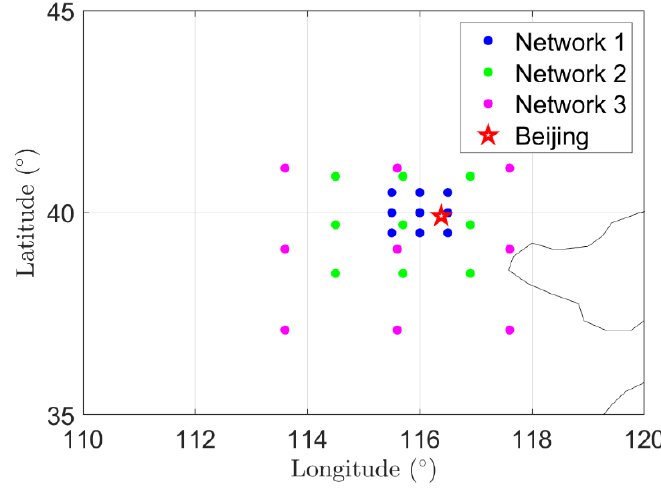
Figure 2. Three networks of different scales used in the tests. Table 3. Details of the networks used in the tests.